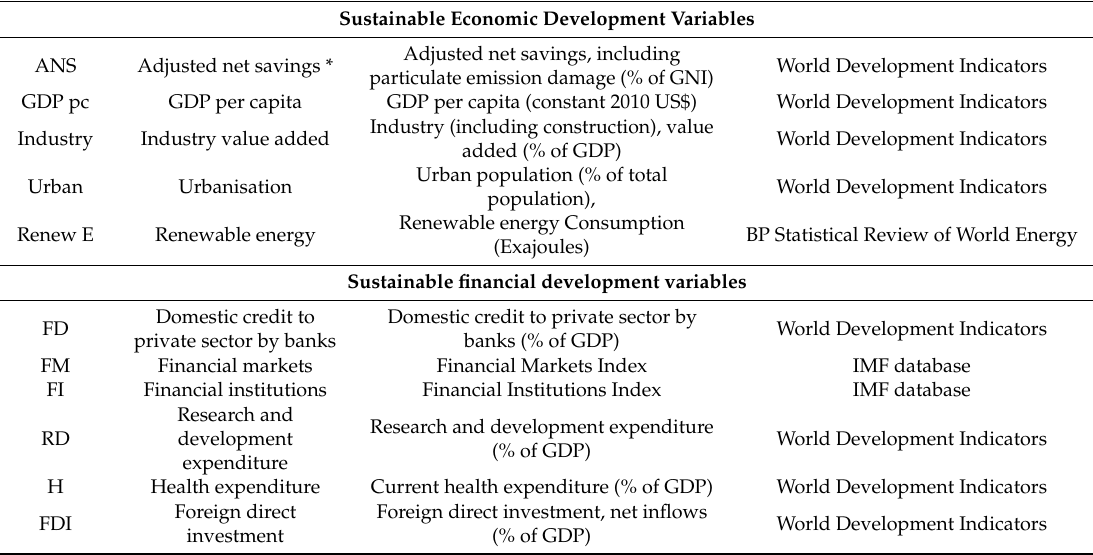
Table 2. Details of variables for sustainable economic and financial